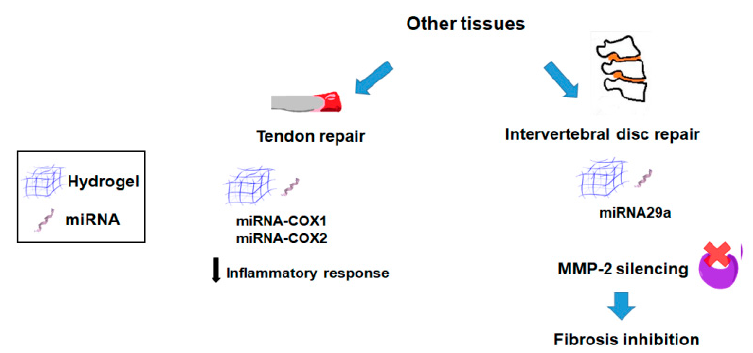
Figure 3. Main strategies involving the use of hydrogel-based nonviral gene delivery systems for repairing other musculoskeletal tissues.